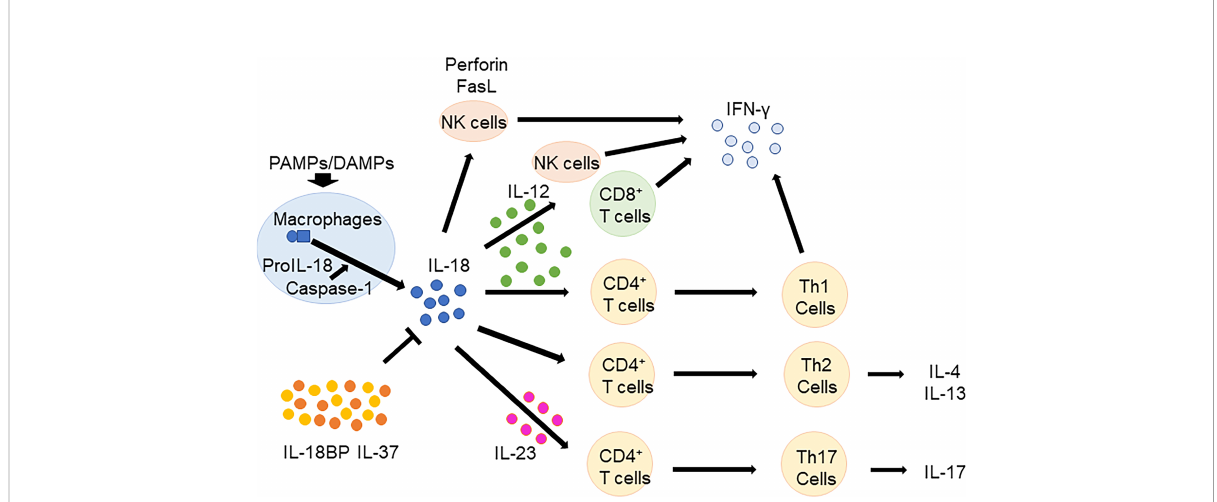
FIGURE 1 Biological functions of IL-18. In the presence of IL-12 and/or IL-15, IL-18 induces IFN- g production in macrophages, NK cells, T cells, and B cells. In the absence of IL-12 or IL-15, IL-18 promotes the differentiation of naïve T cells to Th2 cells, which produce IL-4 and IL-13. Furthermore, IL-18 promotes Th17 cells in combination with IL-23. IL-18 BP and IL-37 regulates IL-18 function. IL, Interleukin; CD, cluster of differentiation; NK, natural killer; IFN, interferon; Th, T helper; BP, binding protein; PAMPs, pathogen associated molecular patterns; DAMPs, damage associated molecular